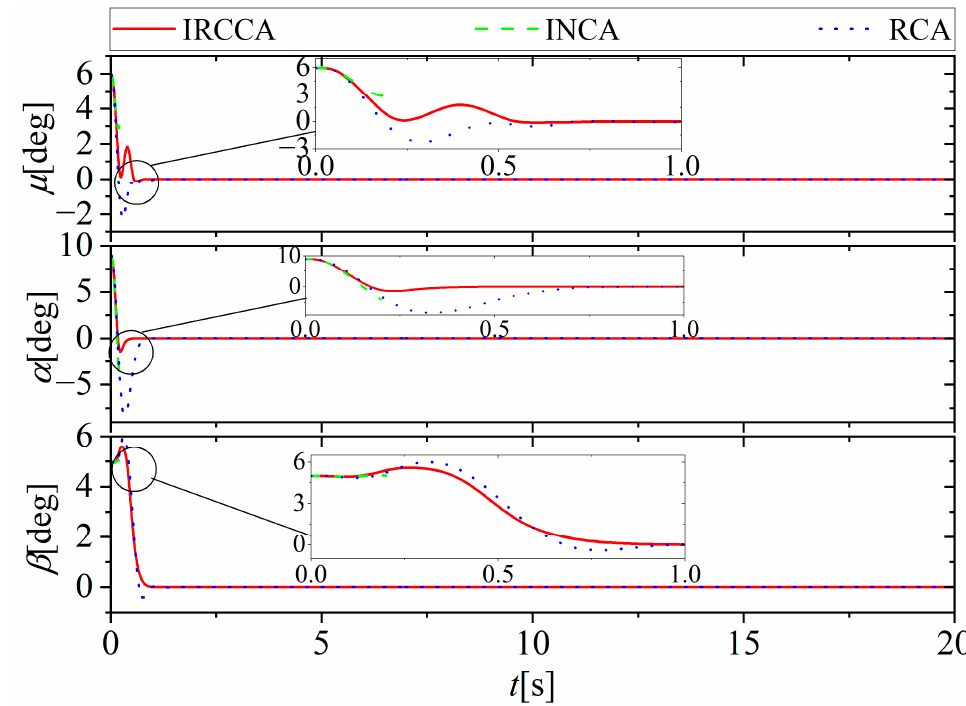
Figure 5. Time response of the attitude angle with lock-in-place fault.